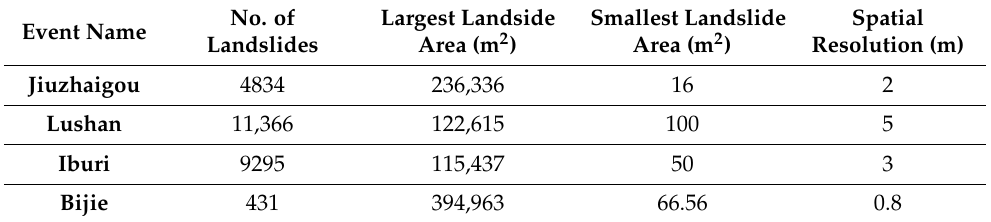
Table 2. General information on each landslide dataset constructed in this